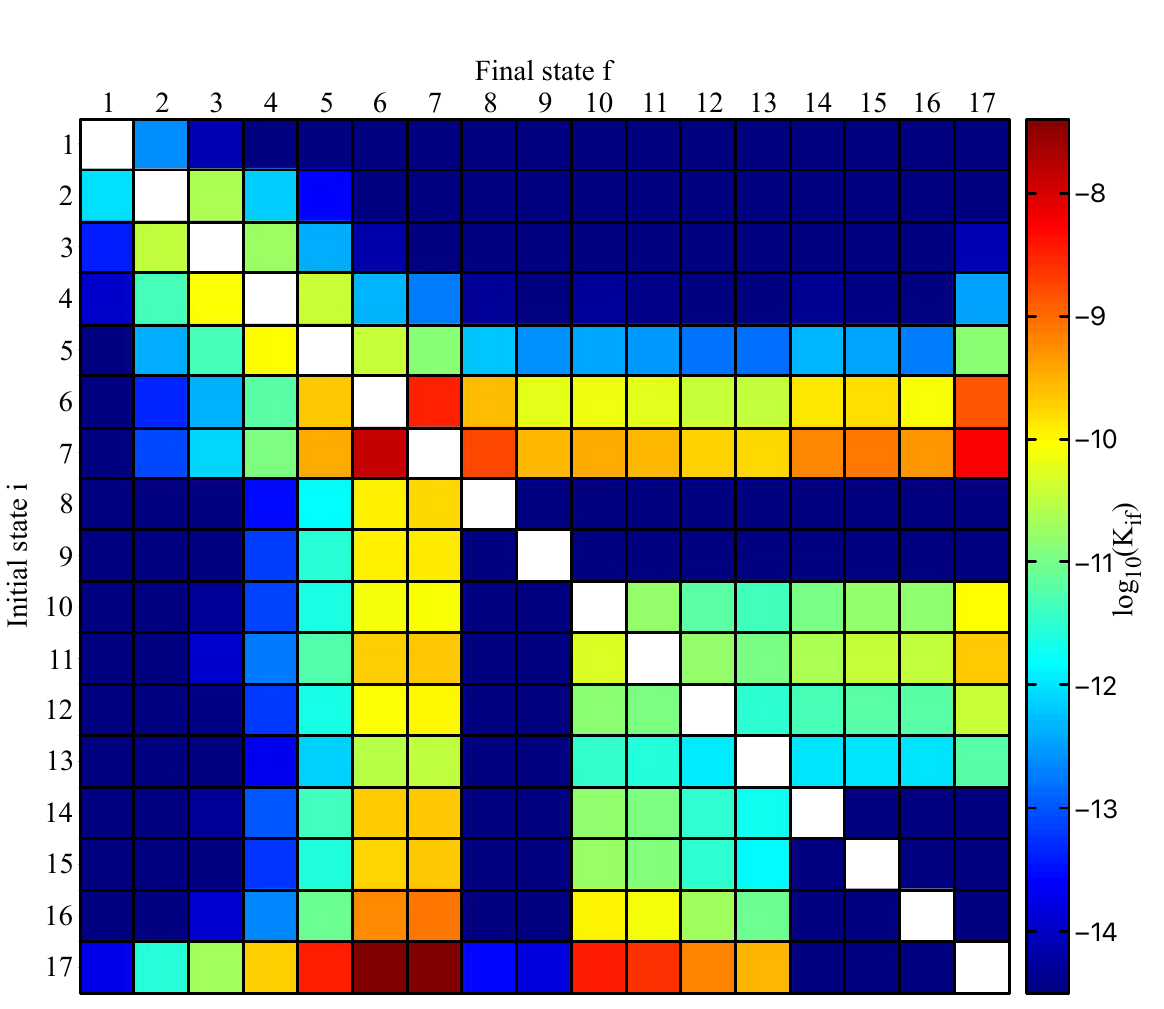
Figure 3. The graphical representation for the inelastic processes rate coefficients in Sr (cid:0) (cid:1) + H ( 1 s 2 S ) and Sr + 5 s 2 S H − ( 1 s 2 1 S ) collisions. The labels for the initial and final states are